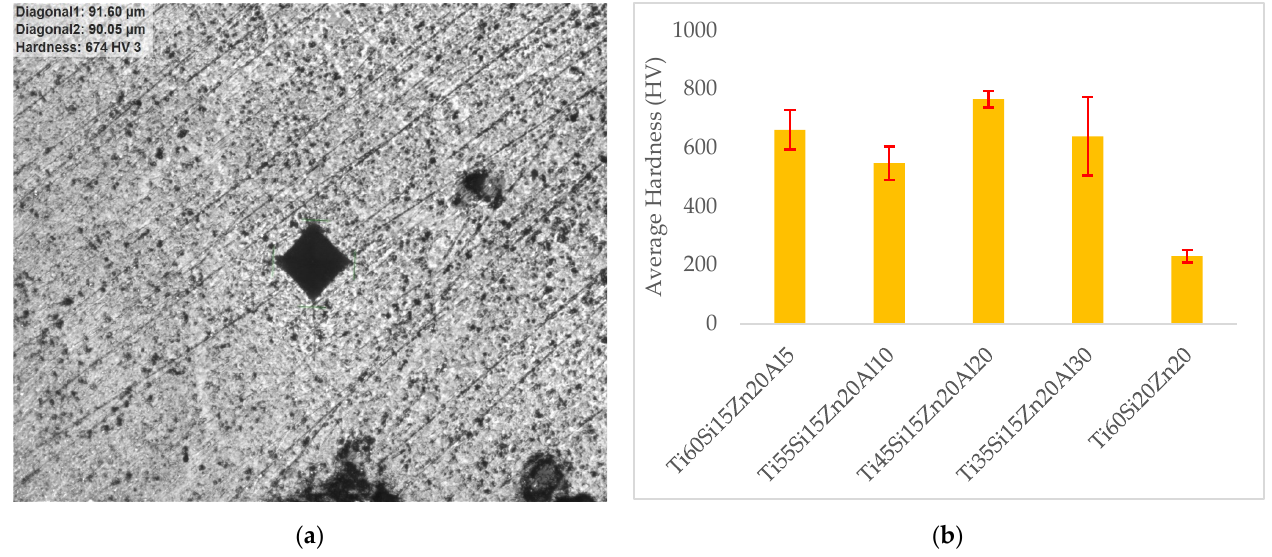
Figure 7. ( a ) An example of the hardness measurement and ( b ) average hardness of the materials.